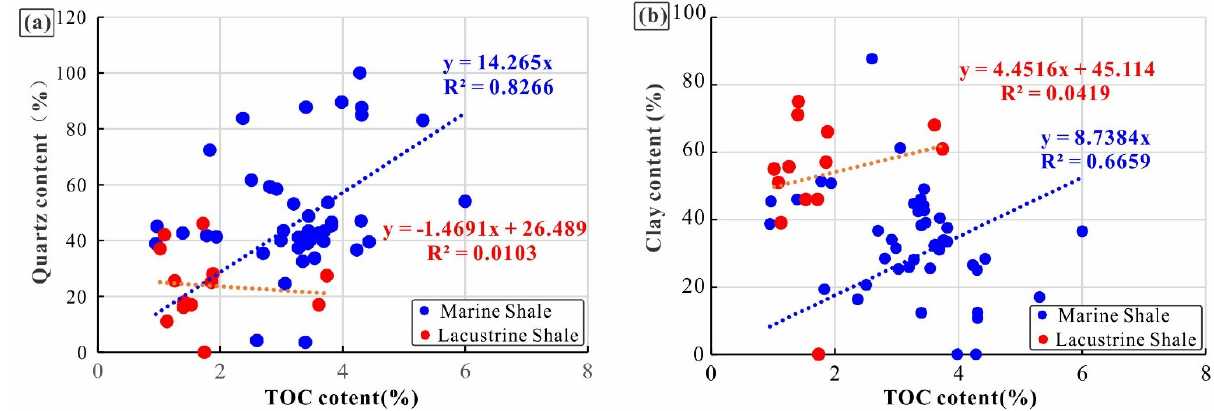
Figure 8. The correlation between TOC and mineral content. ( a ) The correlation between TOC and quartz content. ( b ) The correlation between TOC and clay content.